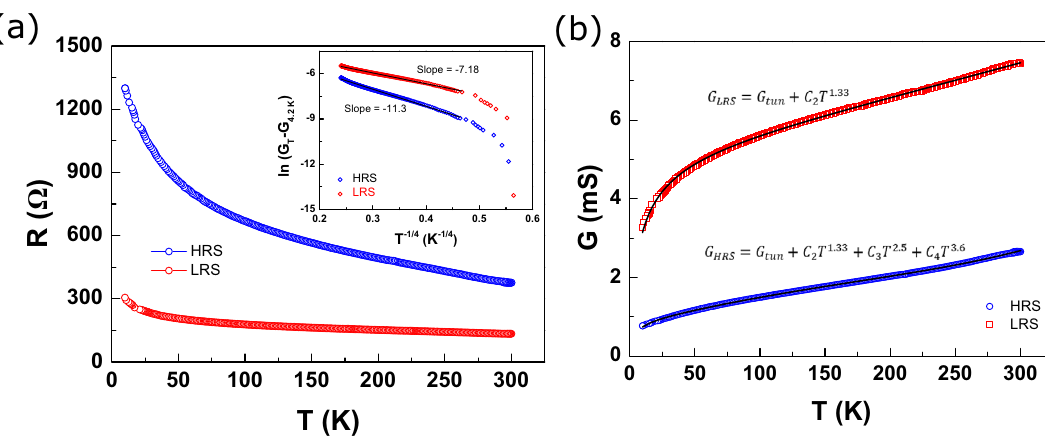
Figure 4. ( a ) The resistance–temperature curves for HRS (blue open circles) and LRS (red open squares). The 1 / 4 inset shows the plot of ln( △ G) versus T − for HRS and LRS with fitting results (solid lines) by using a three- dimensional hopping model. ( b ) The fits of conductivity as a function of temperature for HRS and LRS by a model combining both tunneling and hopping